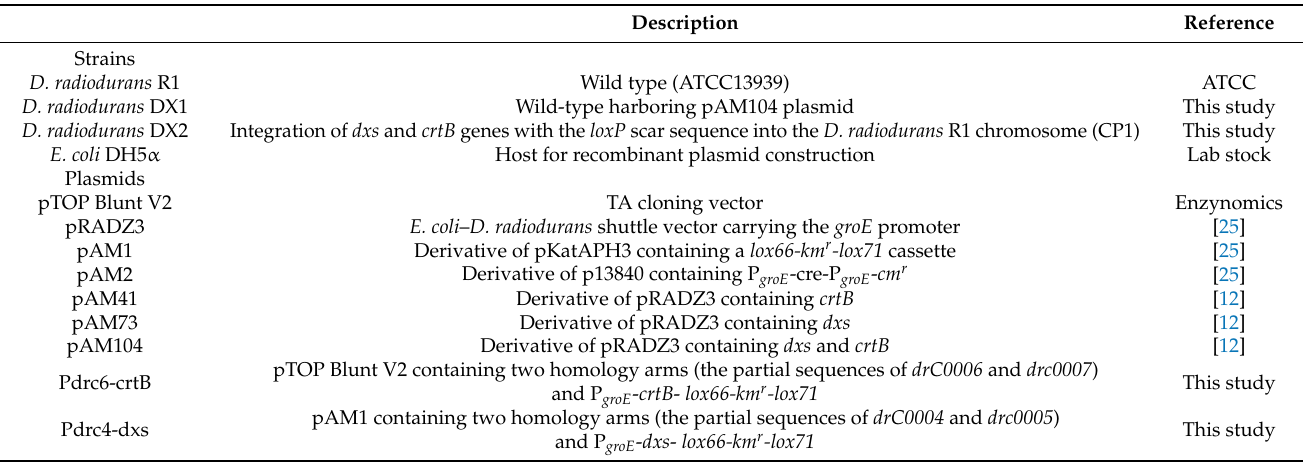
Table 1. Strains and plasmids used in the present